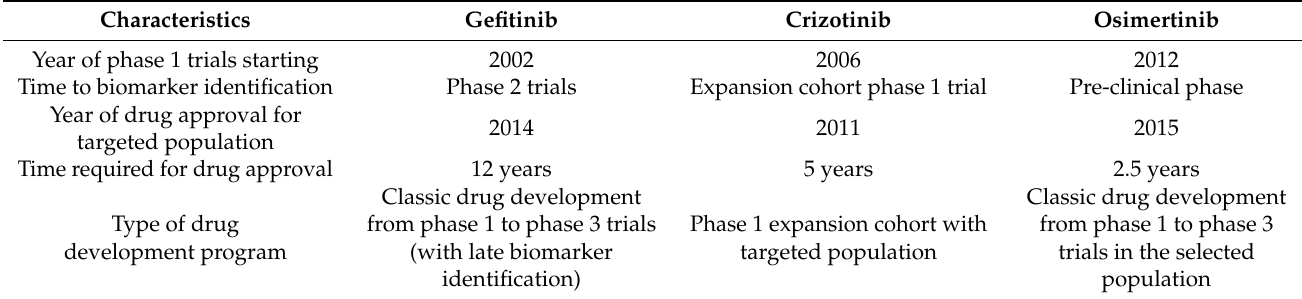
Table 1. Differences in tyrosine kinase inhibitors development